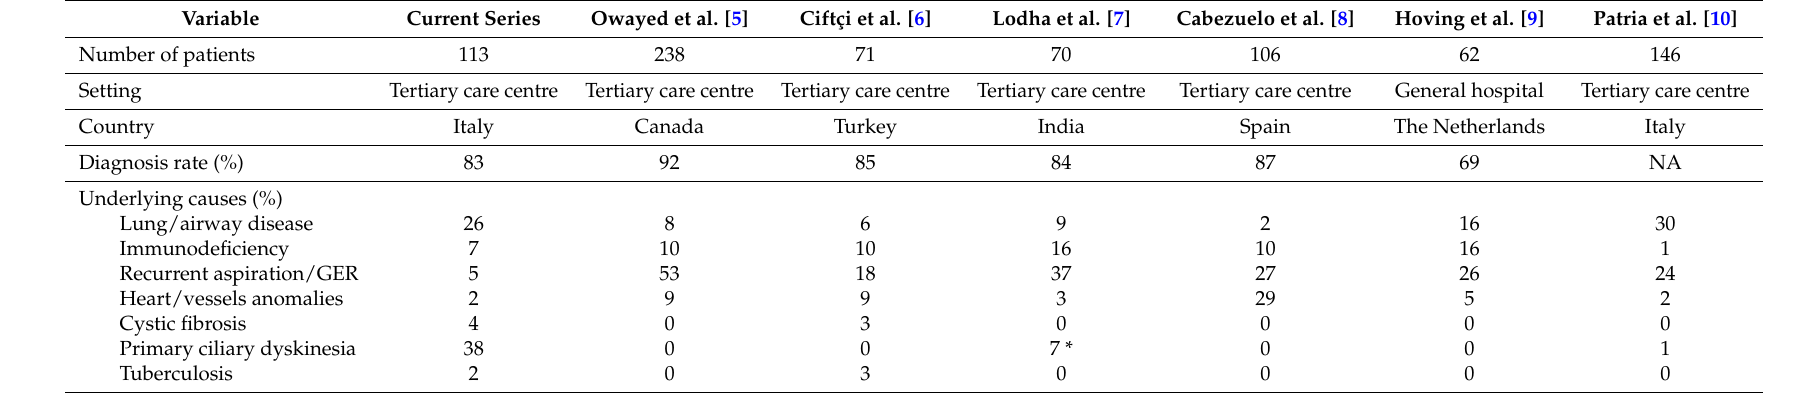
Table 6. Causes of recurrent pneumonia in the current series, compared with previous